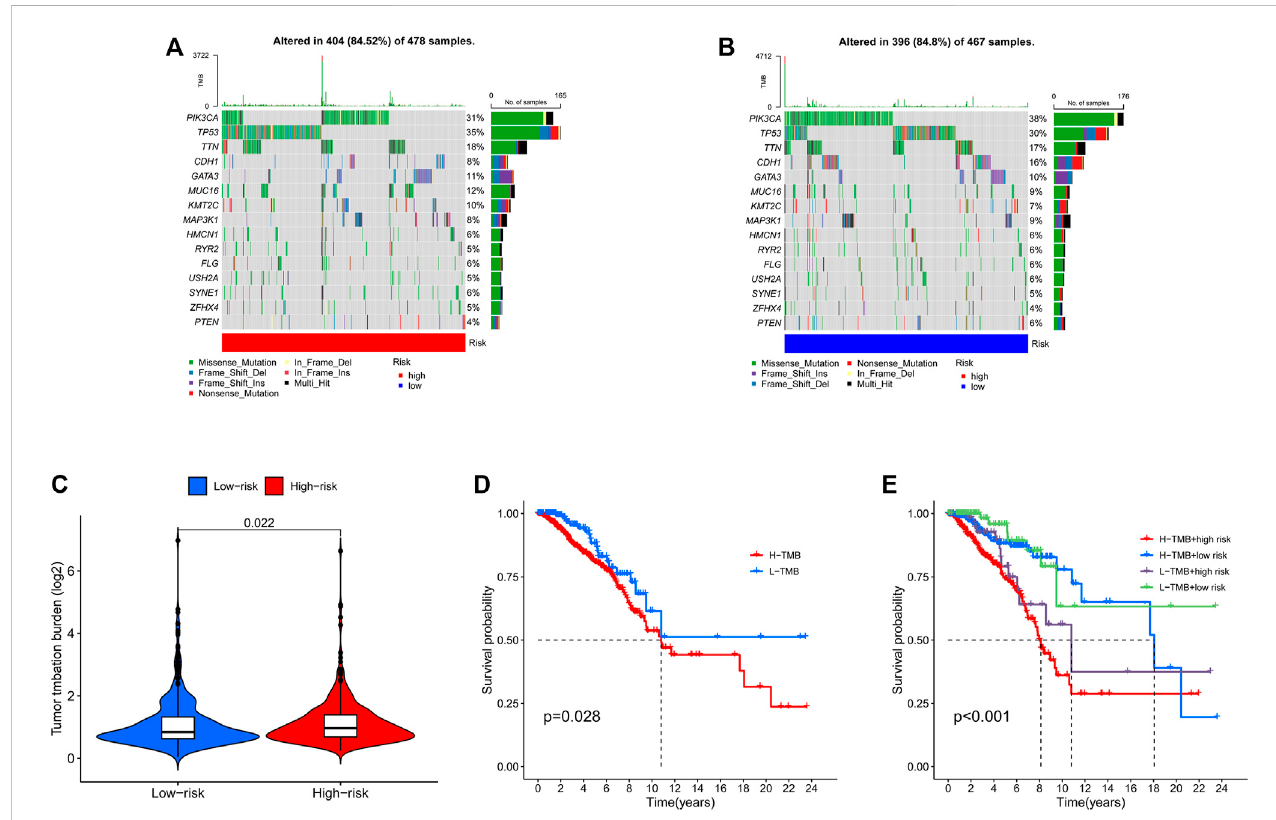
FIGURE 7 Landscape of mutation pro fi les in high- and low-risk BC patients. (A) The TMB in high-risk BC patients. (B) The TMB in low-risk BC patients. (C) The difference of TMB was signi fi cant in BC patients with different risk. (D) The lower TMB was positively correlated with the OS in BC patients. (E) Comparison of OS in BC patients with different risks and different TMBs. BC, breast cancer; TMB, Tumor mutation burden; OS, overall